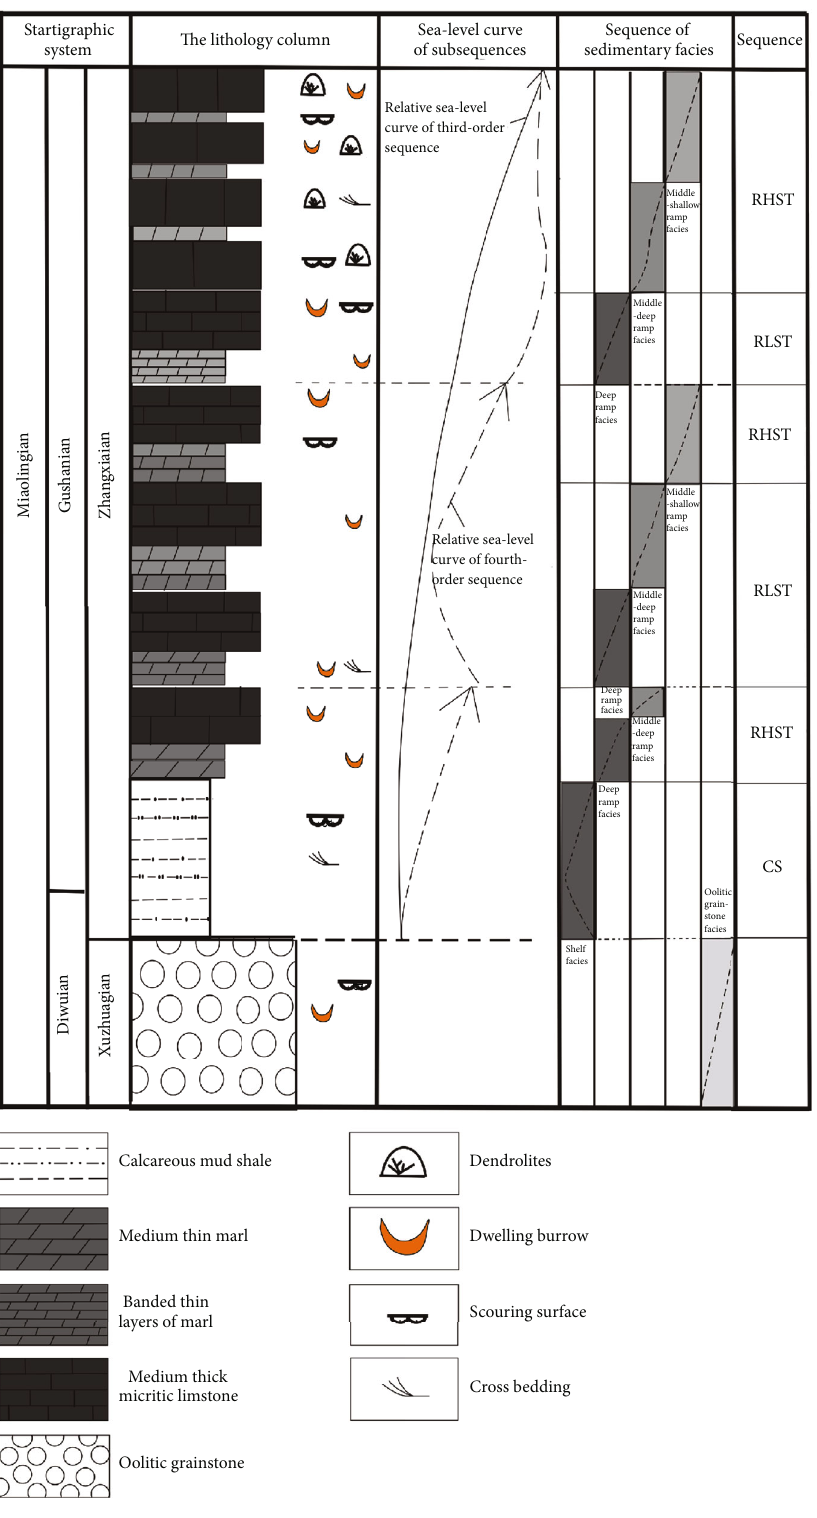
Figure 2: Sequence stratigraphic division of Zhangxia Formation in Houziyu Section, Ezhuang Town, Zibo, Shandong